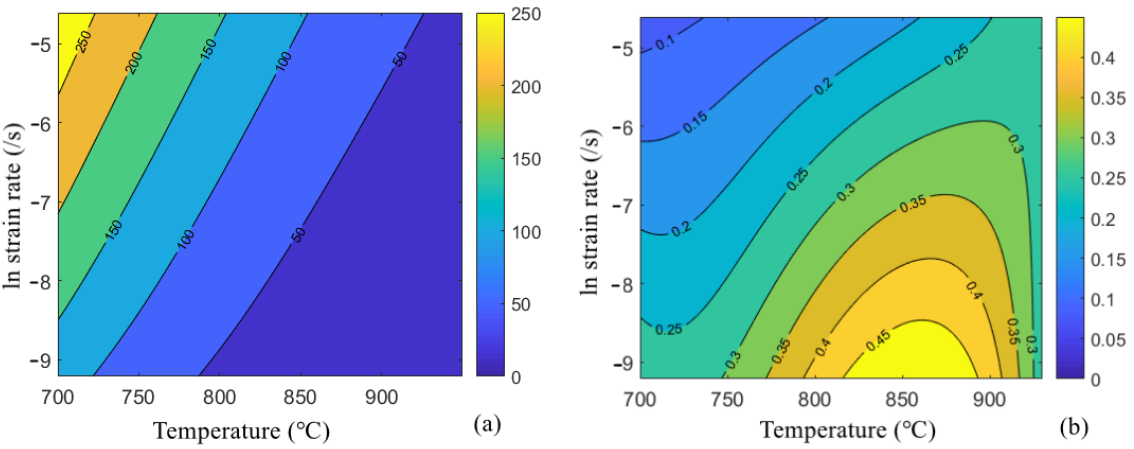
Figure 4. The flow behavior of a Ti-6Al-4V alloy during air cooling at the following temperatures: